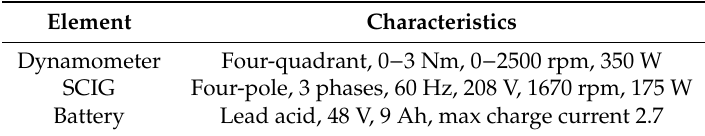
Table 2. Characteristics of the converters and the excitation capacitor bank.